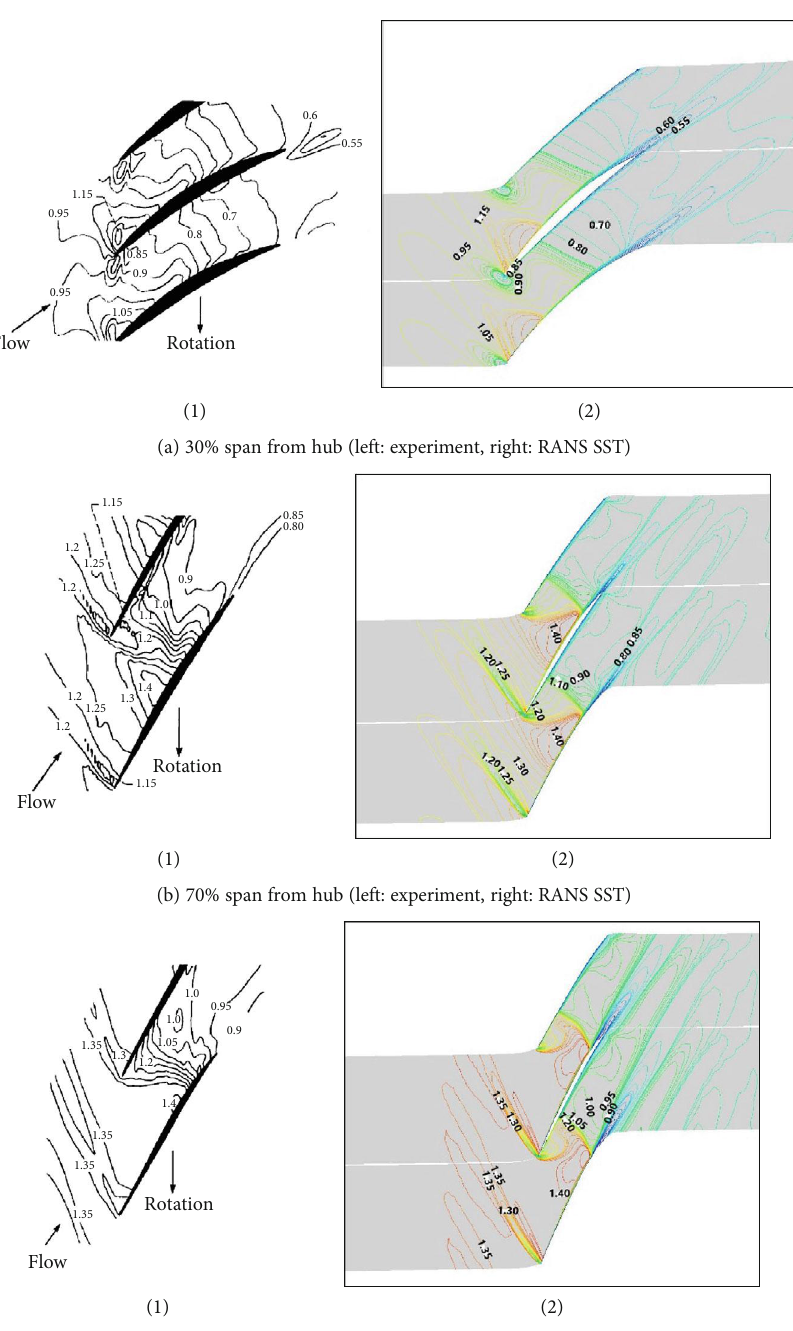
Figure 8: Comparisons of predicted and measured relative Mach number at three typical blade heights for near-peak e ffi ciency